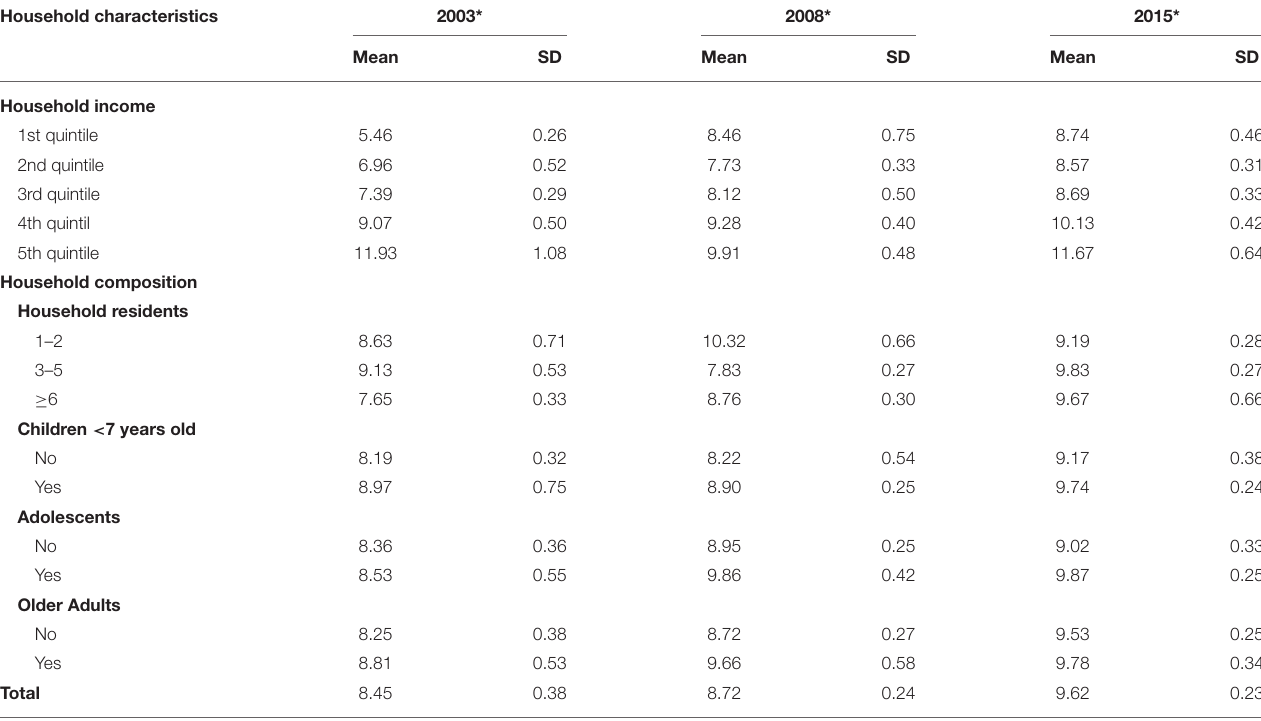
TABLE 5 | Diet costs (mean and SD) according to the household characteristics of individuals interviewed in the ISA-Capital 2003-2015 (São Paulo, Brazil). Household